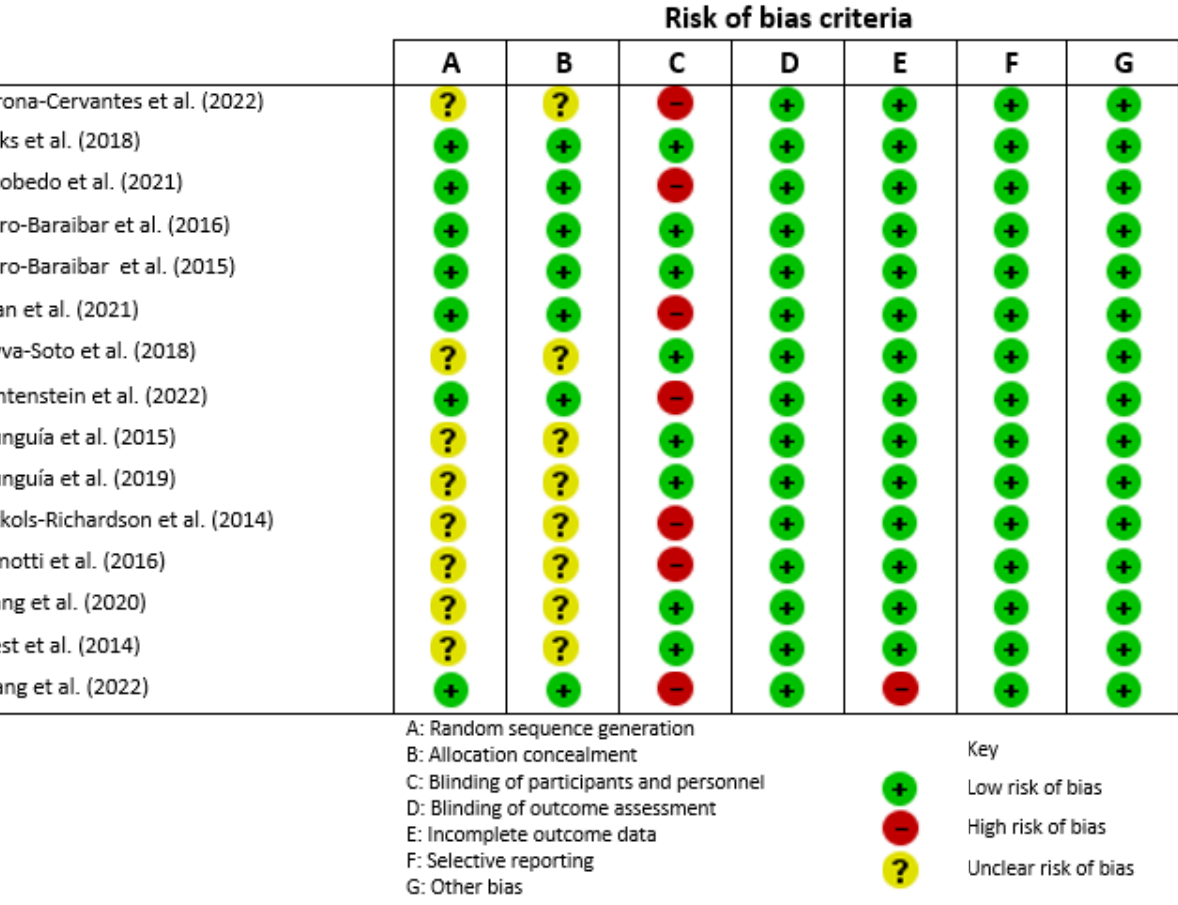
Figure 2. Assessment of the risk of bias in the included studies according to the Cochrane